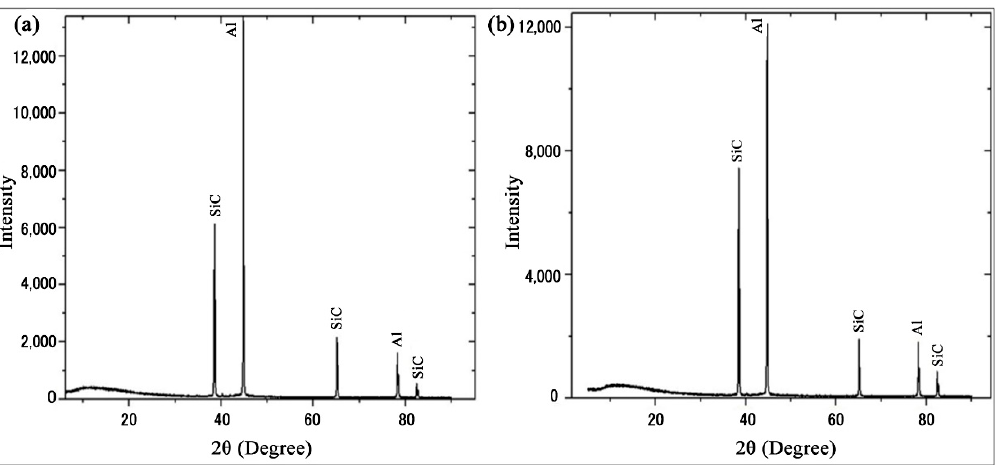
Figure 7. XRD pattern of FSSW joints: ( a ) AA5083/nano-SiC, and ( b ) AA5083/micro-SiC.